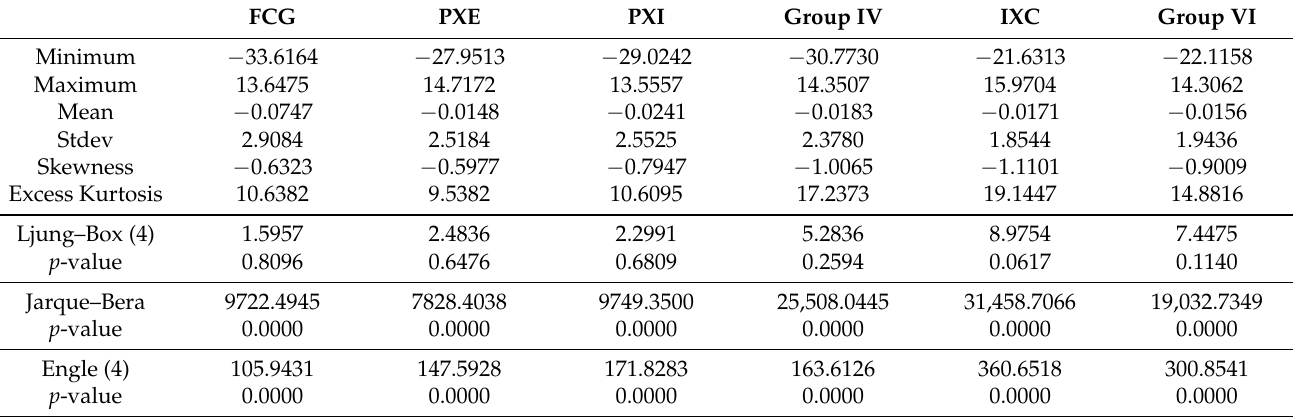
Table A3. Descriptive statistics and tests of percentage logarithmic rates of